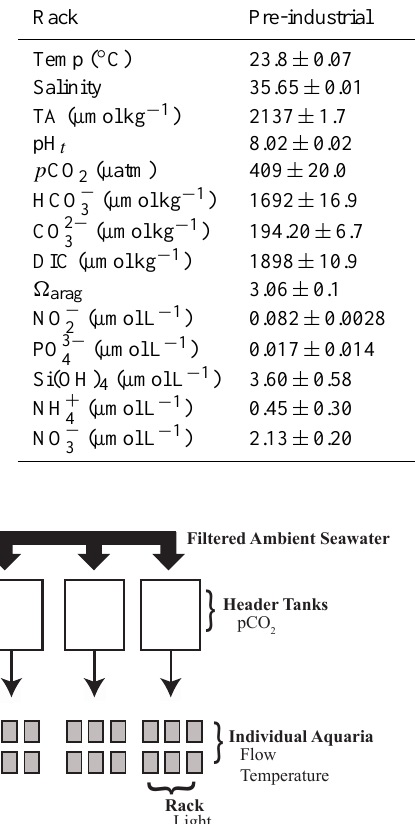
,CO 2 − , DIC, and (cid:127) arag were all calculated from 3 3